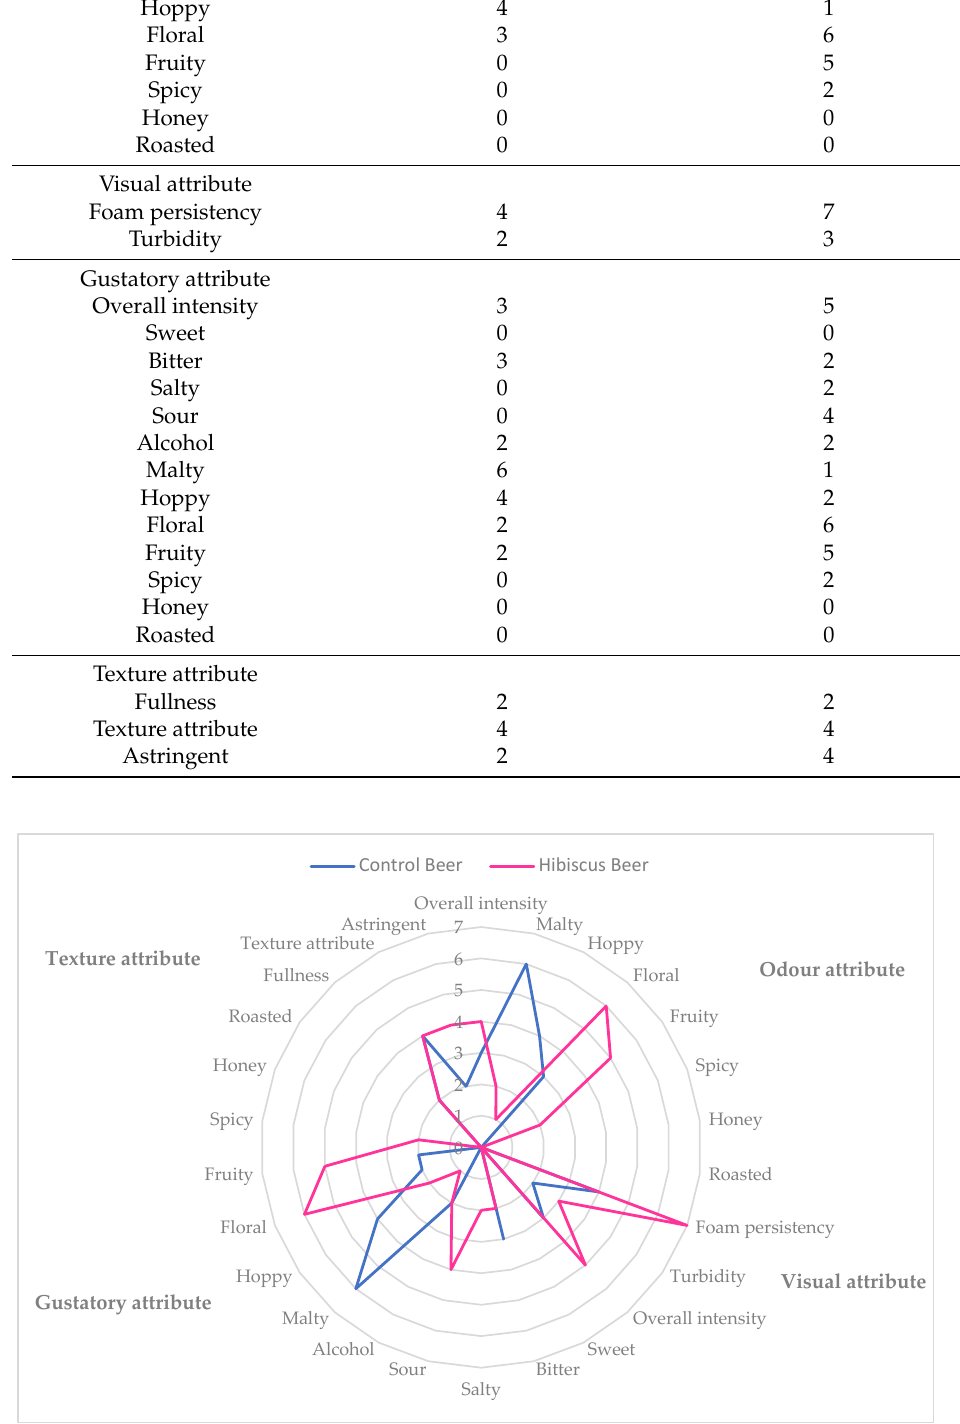
Figure 5. Radar graph of QDA analysis of control and treated beers.